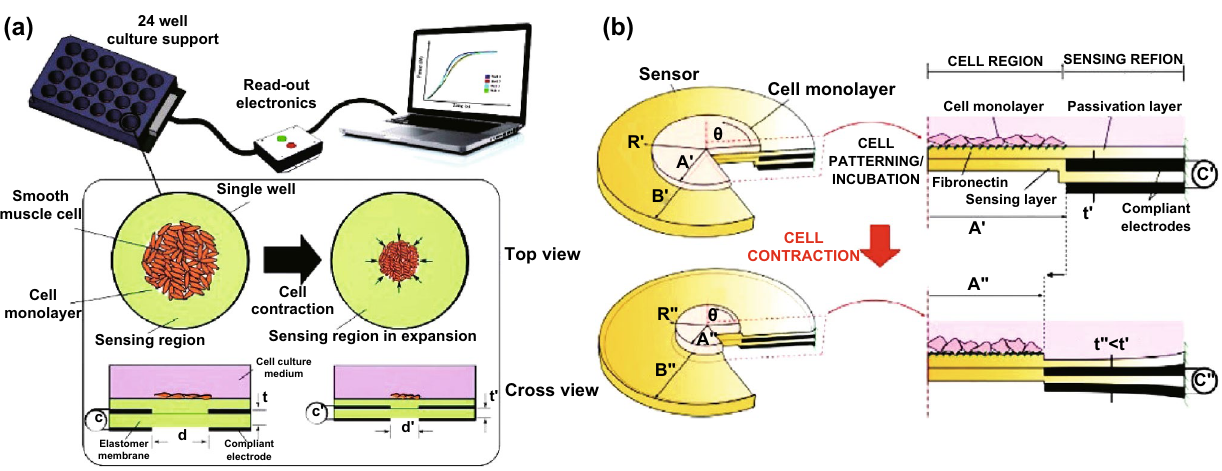
Fig. 7 a Schematic representation of the measure system proposed by Araromi et al. in 2015: The 24-well cell culture supports are equipped with integrated strain and force measurement sensors that are based on DEA. Besides, the electrical read-out allows for high-throughput parallel measurement in real time. Adapted from Ref. [91] with permission. b Optimization of the DEA-based sensors. Parameters such as R , θ , A , and B are used to model the system. Adapted from Ref. [92] with